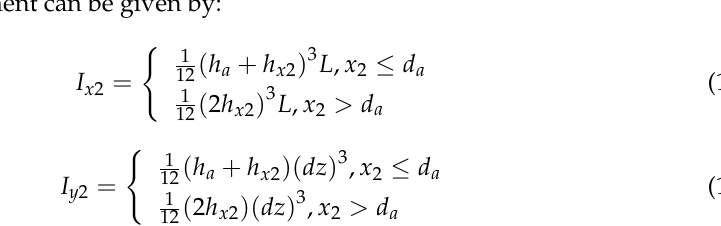
Figure 4 is the schematic diagram of a cracked gear tooth with slice method.